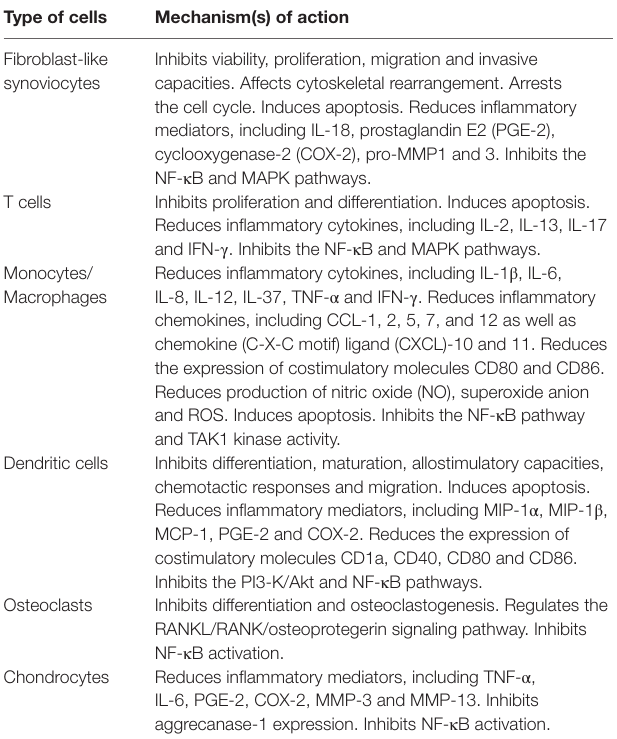
TABLE 1 | Cellular target(s) modulated by triptolide in rheumatoid arthritis. Type of cells Mechanism(s) of action Fibroblast-like synoviocytes